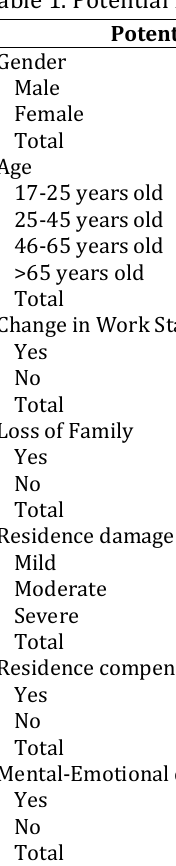
Table 2. Analysis of Potential Factors Correlated to Mental-Emotional Disorder Potential Factors